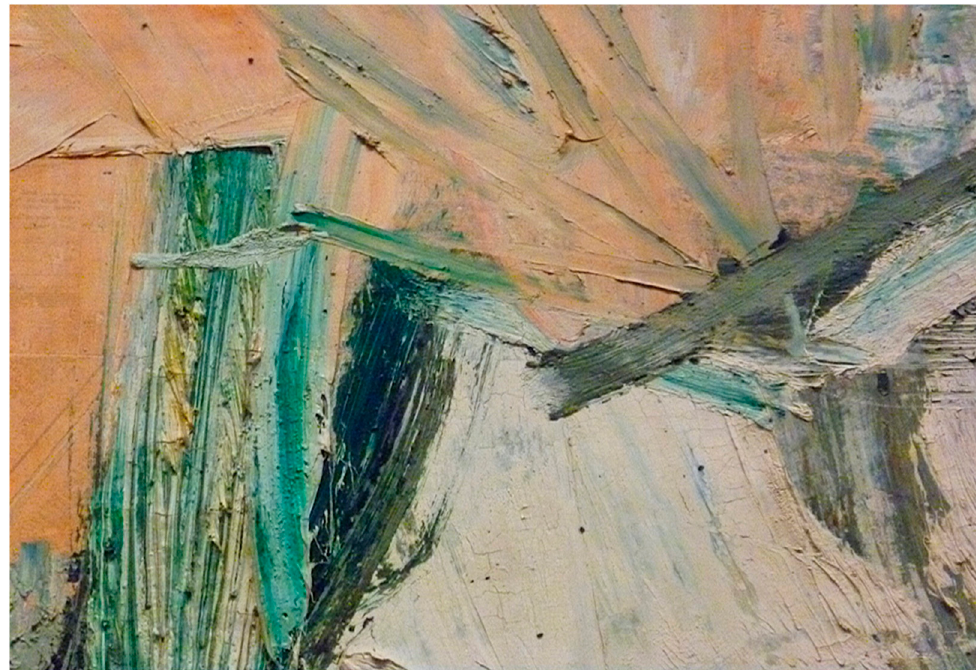
Figure 2. Easter Monday